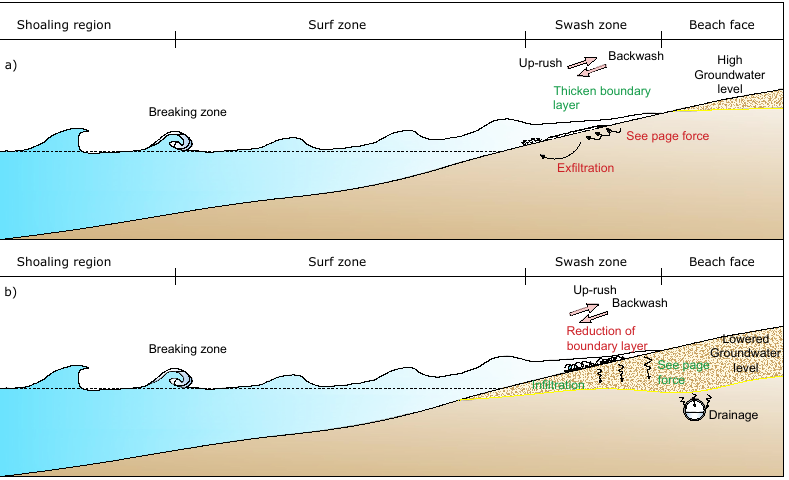
Figure 2. Scheme of the interaction between the groundwater table and wave run-up. Panel ( a ) refers to natural high groundwater level. Panel ( b ) refers to lowered groundwater level. Green labels point out the stabilizing effects, red ones refer to mobilizing